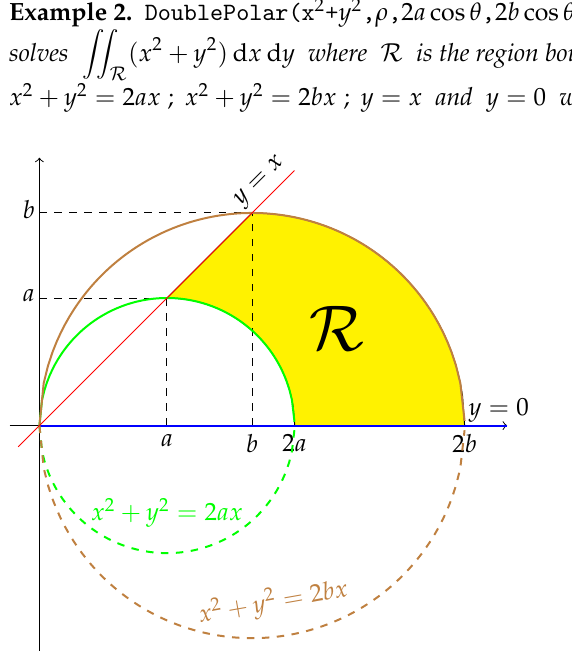
Figure 2. Region bounded by x 2 + y 2 = 2 ax ; x 2 + y 2 = 2 bx ; y = x and y =